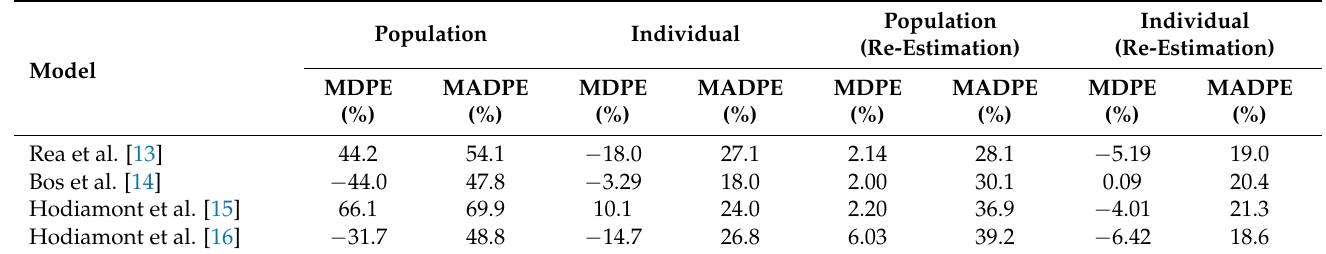
Table 2. Prediction error following external evaluation of the PopPK models.